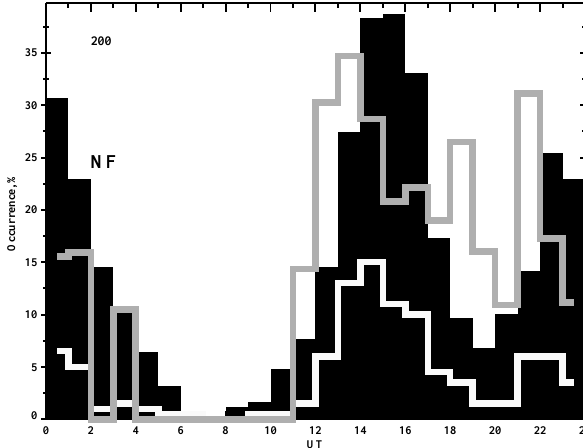
Fig. 3. Diurnal variation of the STARE echo occurrence in the cells closest to the IRIS beam 41 for 2000–2001 with the black (grey) rectangles/line showing the Norway (Finland) echo occurrence. Each 1-h period of high CNA/SNR correlation ( C na ,C fa > 0.4) is shown by the horizontal line with the distance from the bottom cor- responding to the time of the year, as shown on the right axis. The heavy line shows the diurnal variation of the total (for each 1-h in- terval) number of high correlation periods (HCPs) normalized to the total (for all 24h) number of HCPs shown in the top left corner.